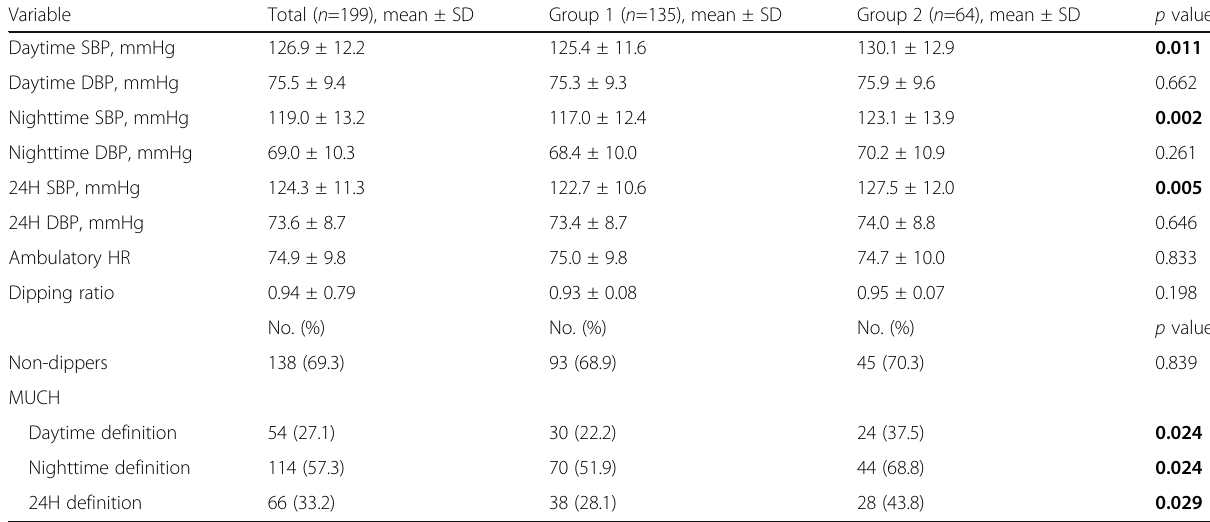
Table 3 Ambulatory blood pressure